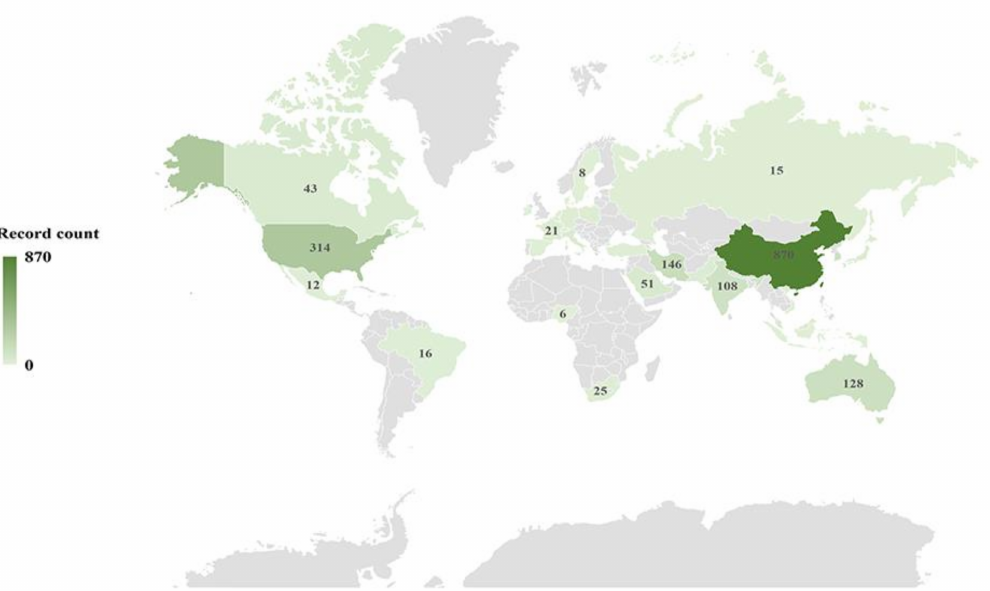
Figure 2. Worldwide geographical distribution of the graphene-based membranes on